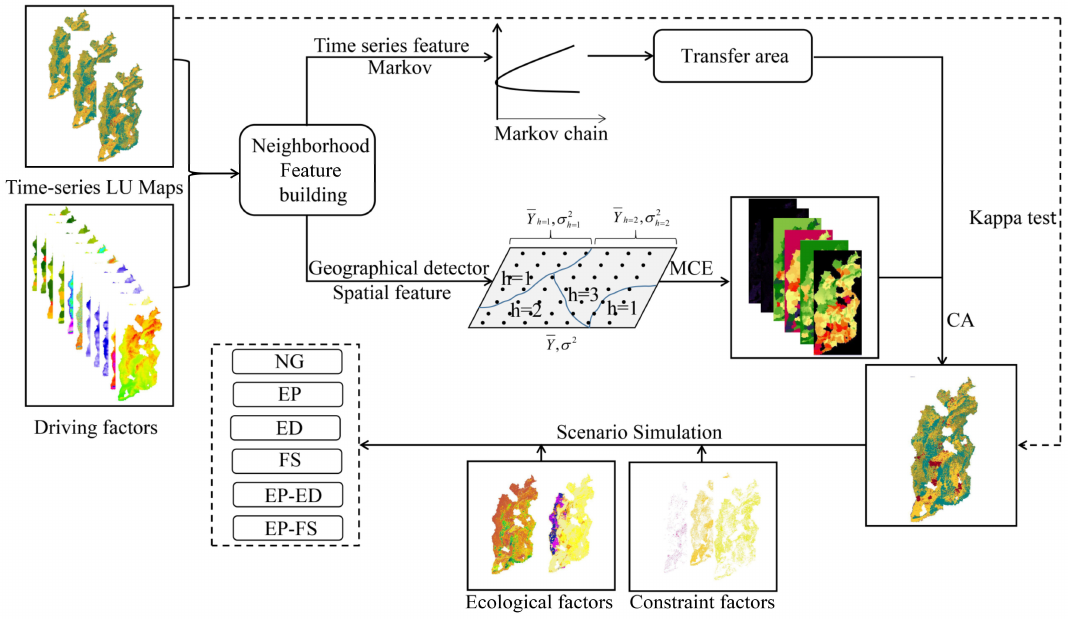
Figure 4. Schematic showing the design framework for this